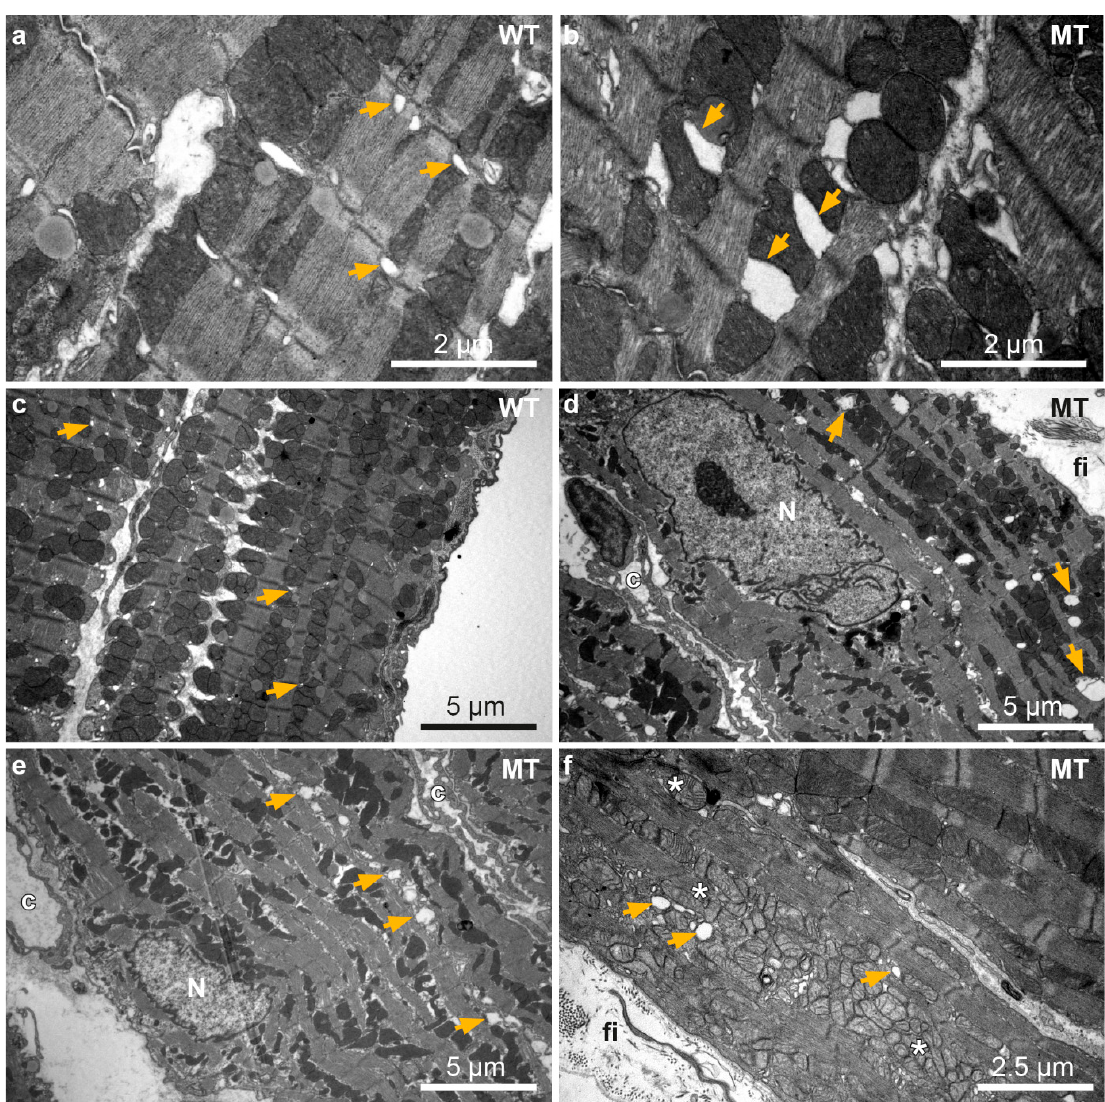
Figure 6. Ultrastructural analysis reveals sarcoplasmic reticulum (SR) dilation in Dsg2 MT hearts. Transmission electron microscopy images of 12 and 30 week-old wild-type (WT; ( a , c )) and Dsg2 MT mice (MT; ( b , d – f )) are shown. ( a , b ) show left and ( c – f ) right ventricles. Cardiomyocytes with enlarged ER/SR lumina are occasionally detected in Dsg2 MT mice at 12 weeks (( b ); orange arrow). At the age of 30 weeks more cardiomyocytes of Dsg2 MT mice present dilated ER/SR (orange arrows) and mitochondria with rarefied cristae (*; ( d – f )). Note that cardiomyocytes with dilated ER/SR and/or mitochondria are located adjacent to strands of interstitial fibrosis (fi). Capillaries are marked with “c”.